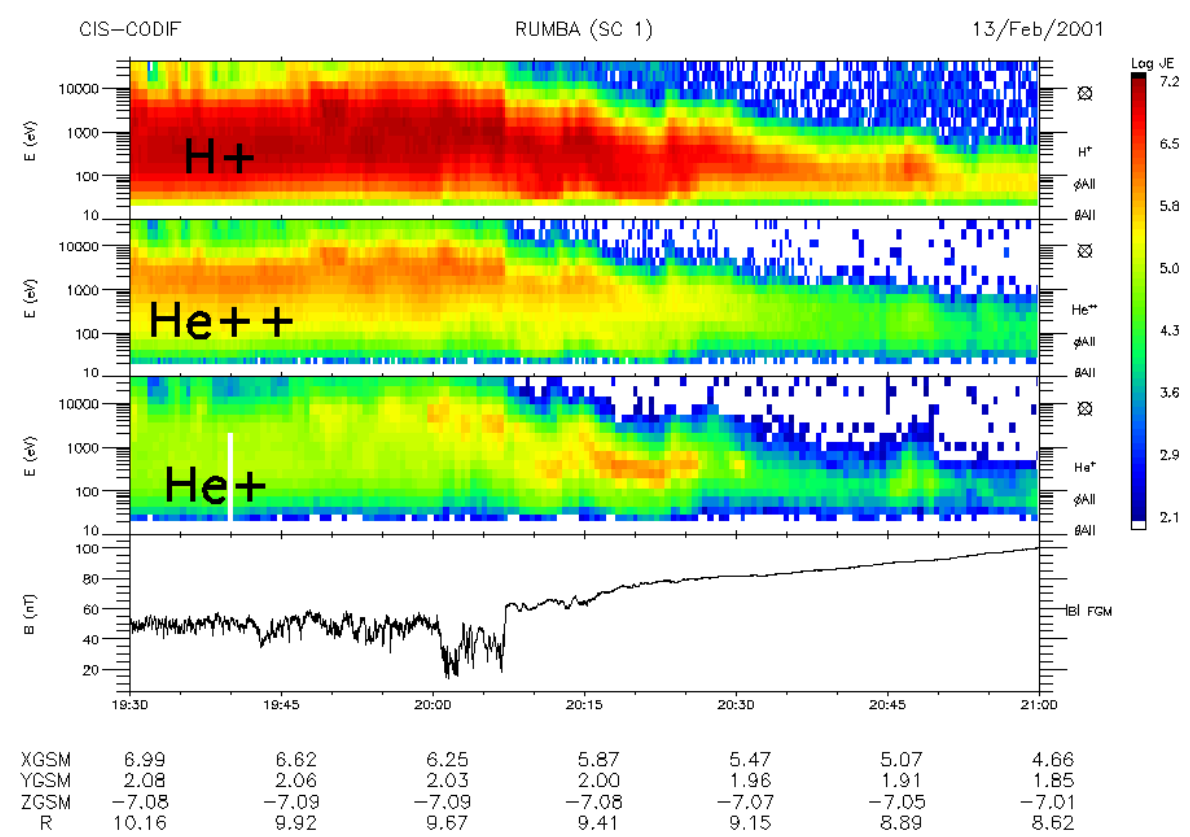
Fig. 5. Data from the CODIF instrument on spacecraft 1 between 19:45 and 21:00 on 13 February 2001. The three colour panels show the energy spectrograms for H + , He ++ and He + , respectively, between 10 and 40000eV. The flux colour palate is shown at the right. For context, the lower panel shows the magnetic field